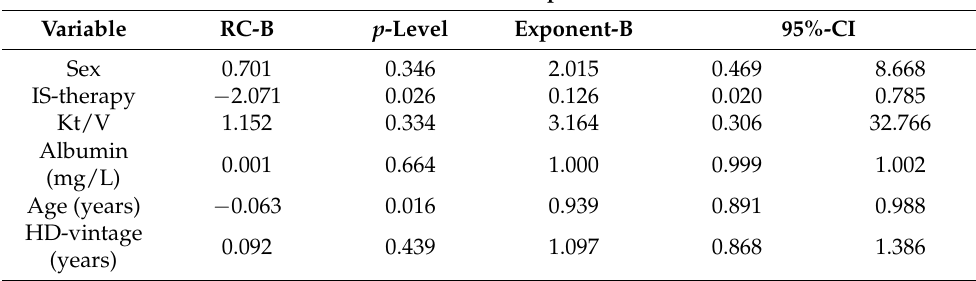
interval of exponent-B. KTx = kidney transplantation, IS = immunosuppressive, eGFR = CKD-EPI formula in ml/min/1.73 m 2 BSA, n.a. = not